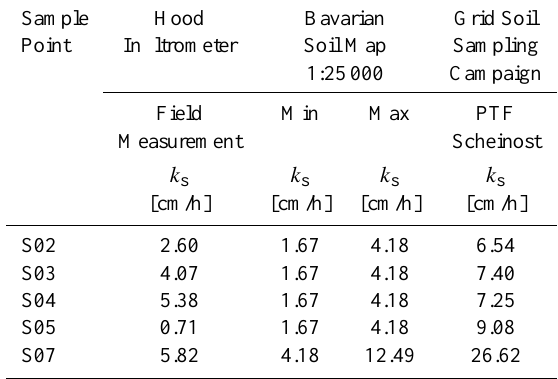
Table 5. Soil type according to grain size distribution (German soil classification).